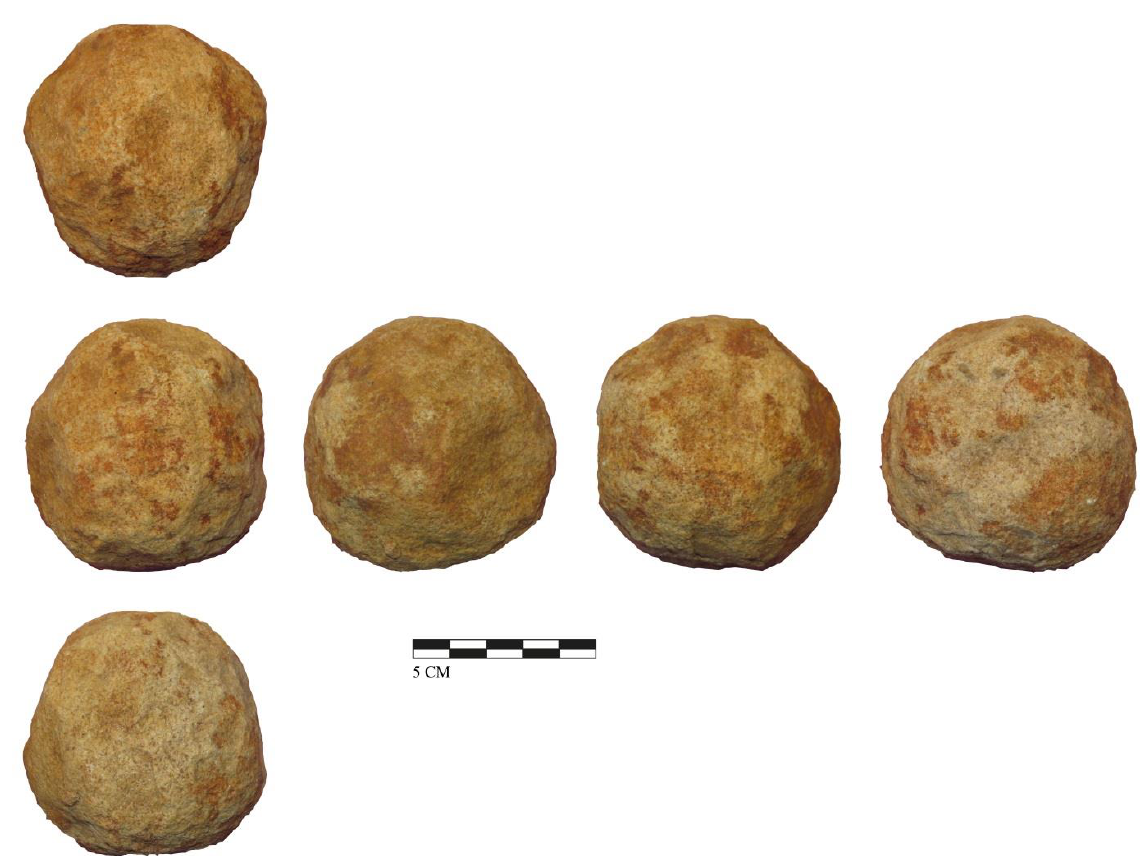
Figure 12. Bola. Percussion scars are almost completely deleted by crushing and pecking of the